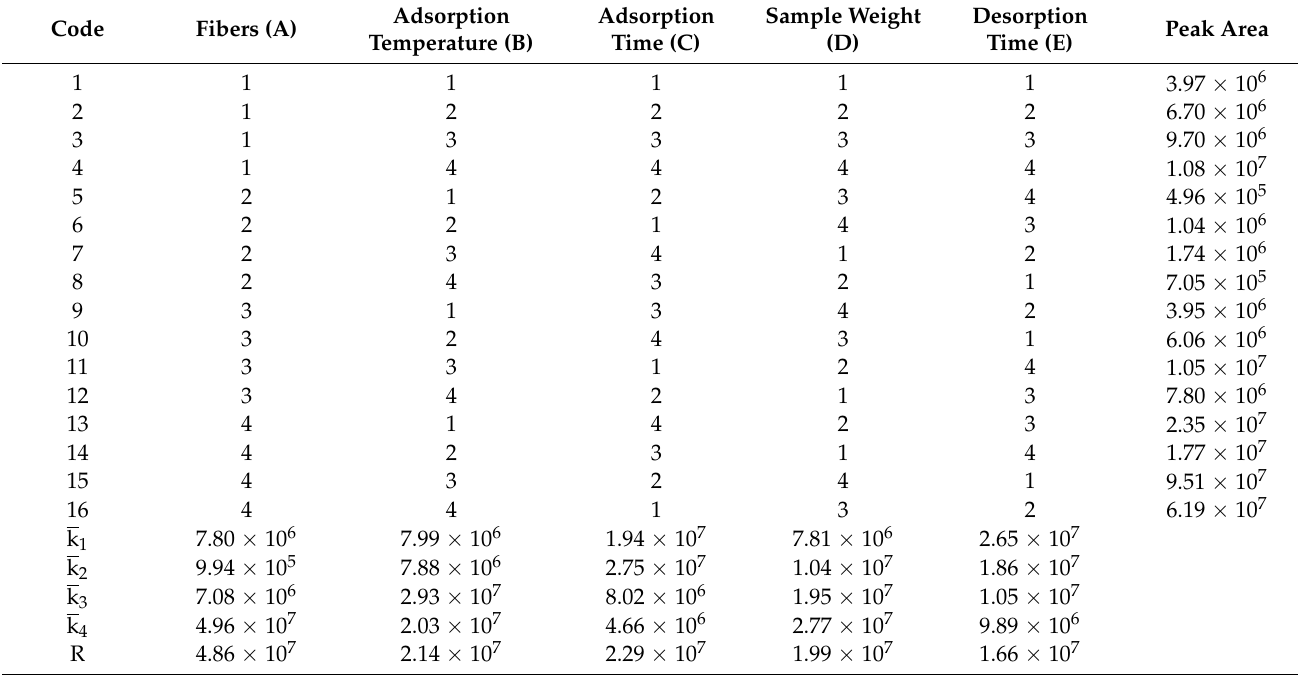
Table 2. Optimized results of HS-SPME parameters by an L 16 (4 5 ) orthogonal test.